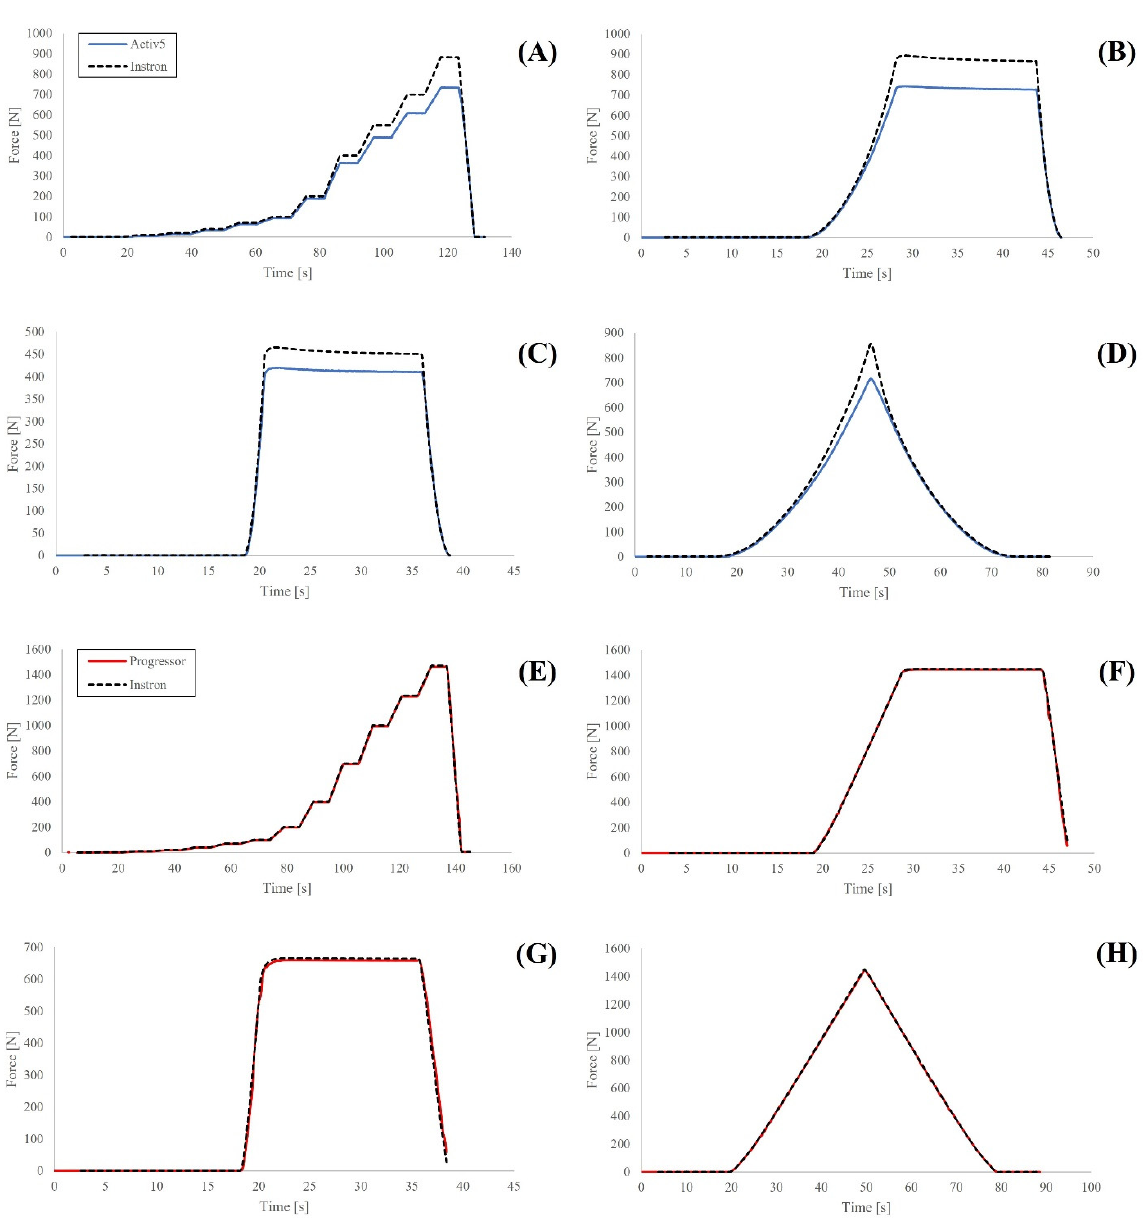
Figure 2. Loading profiles of the ActivBody Activ5 compared to the gold standard (Instron) for ( A ) Stepped Load Test; ( B ) Stress Relaxation Test; ( C ) Simulated Exercise Test; and ( D ) Hysteresis Test. Additionally, loading profiles of the Tindeq Progressor compared to the gold standard (Instron) for ( E ) Stepped Load Test; ( F ) Stress Relaxation Test; ( G ) Simulated Exercise Test; and ( H ) Hysteresis Test.